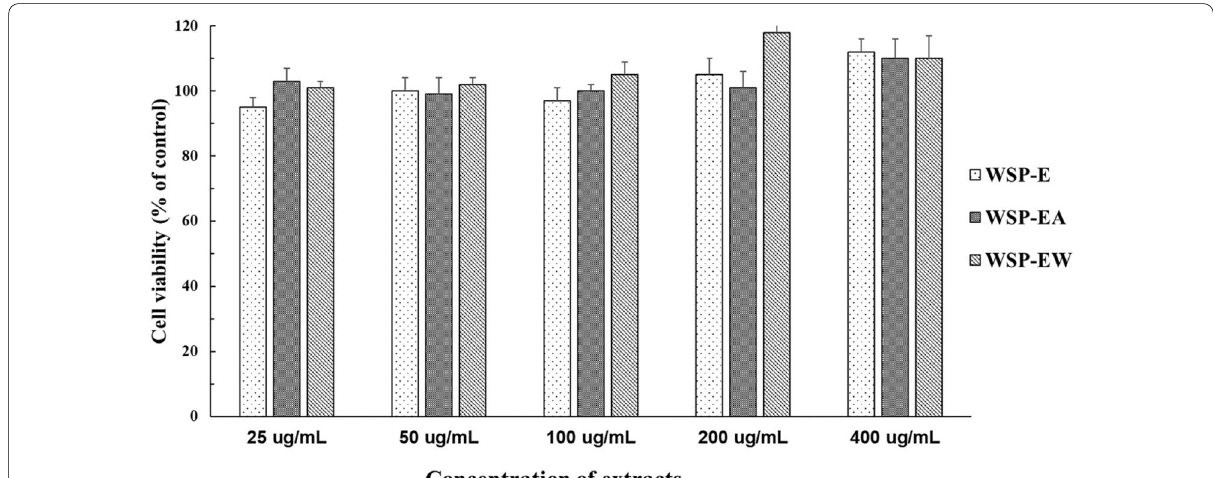
Fig. 3 C2C12 myotubes viability evaluated by MTT assay in different WSP extracts and concentration from 25 µg/mL to 400 µg/mL for 24 h at 37 °C. WSP-E white sweet potato ethanol extract, WSP-EA white sweet potato ethyl‑acetate fraction, WSP-EW white sweet potato water fraction. Values were presented as mean SD of 3 independent experiments performed in triplicate, and were analyzed using one‑way ANOVA, followed by a post ± hoc Tukey’s test for multiple